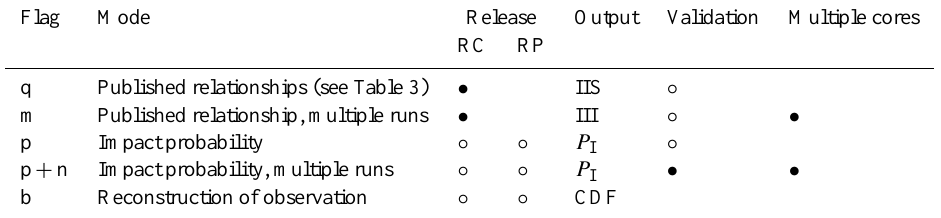
Table 2. Possibilities to define the break criteria. The flags provided through the command line or the user interface define the type of break criterion. RC is release coordinates (release from highest points of release areas), RP is release pixels (release from all pixels within release areas), • is relevant for most applications, and ◦ is relevant for some